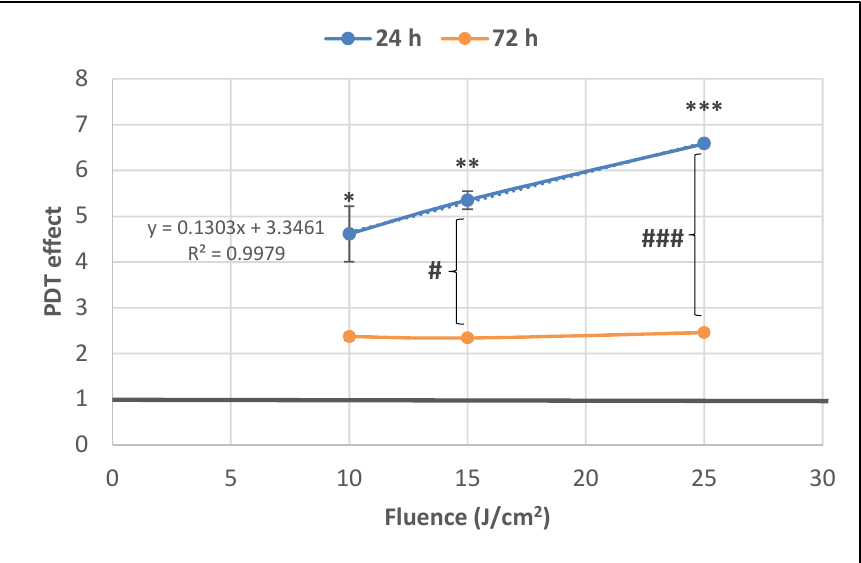
Figure 7. The dependence of LDH release by PDT-treated HT29 tumor cells on the fluence of the activating light delivered at a fluence rate of 50 mW/cm 2 . Analysis was performed at 24 h and 72 h post-PDT. Results are presented as PDT effect (mean ± SEM) in triplicate samples. PDT effect was calculated as OD in samples subjected to PDT divided by the mean value of OD in control samples. Comparison between samples was performed using Student’s t -test considering unequal variances: comparison between PDT regimens at a specific time-point: * p < 0.05, ** p < 0.01, *** p < 0.001; comparison between samples at 24 h and 72 h: # p < 0.05, ### p <